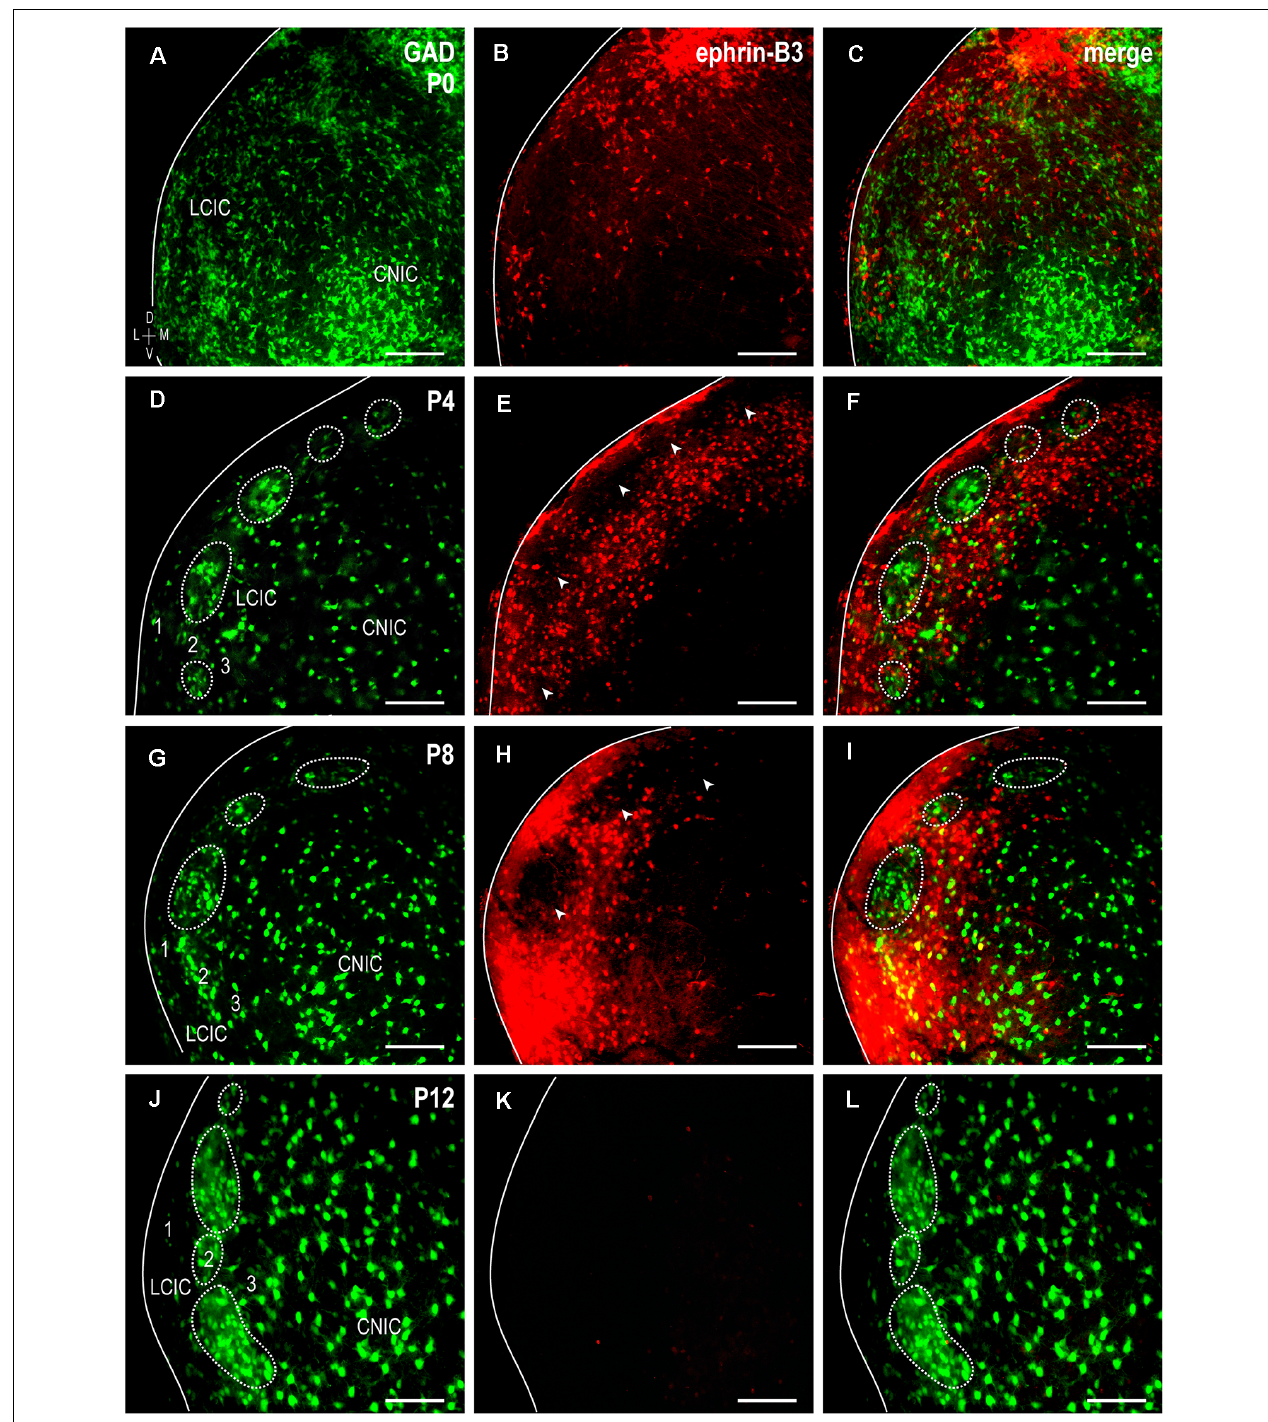
FIGURE 1 | Developmental progression of GAD67-GFP and ephrin-B3 expression patterns in the neonatal lateral cortex of the inferior colliculus (LCIC). Transient ephrin-B3 expression (red) with respect to developing glutamic acid decarboxylase (GAD)-positive modules (green) at P0 (A–C) , P4 (D–F) , P8 (G–I) , and P12 (J–L) . At birth, GAD-positive modules are in early development and are not readily identifiable, and ephrin-B3, while present in the LCIC, does not yet exhibit any clear compartmental organization. By P4, modules are distinguishable (dashed contours) and become more evident with age. Over this critical period for emerging LCIC compartments, the ephrin-B3 expression is complementary to that of GAD and preferentially restricted to the surrounding LCIC matrix. Note discrete layer 2 modular voids at P4 and P8 ( E,H , arrowheads), encompassed by concentrated ephrin-B3 expression. With the modular-extramodular framework and afferent patterns largely in place by P12 ( see Lamb-Echegaray et al., 2019), LCIC ephrin-B3 expression appears strikingly downregulated (K,L) . Scale bars = 100 µ m.